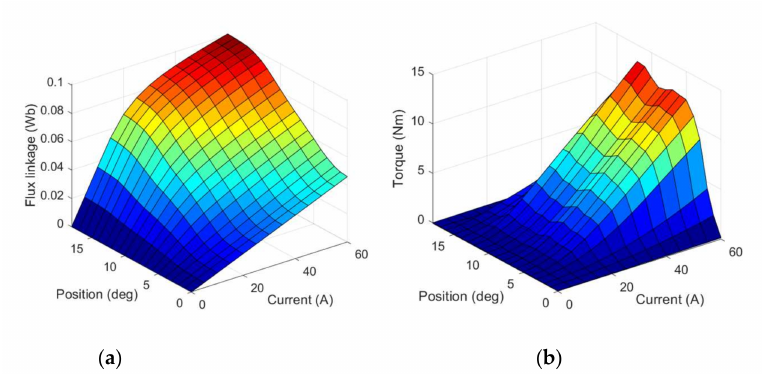
Figure 8. ( a ) Flux linkage prediction based on MCC-LSSVR model with respect to phase current and position angle, ( b ) torque prediction based on MCC-LSSVR model with respect to phase current and position